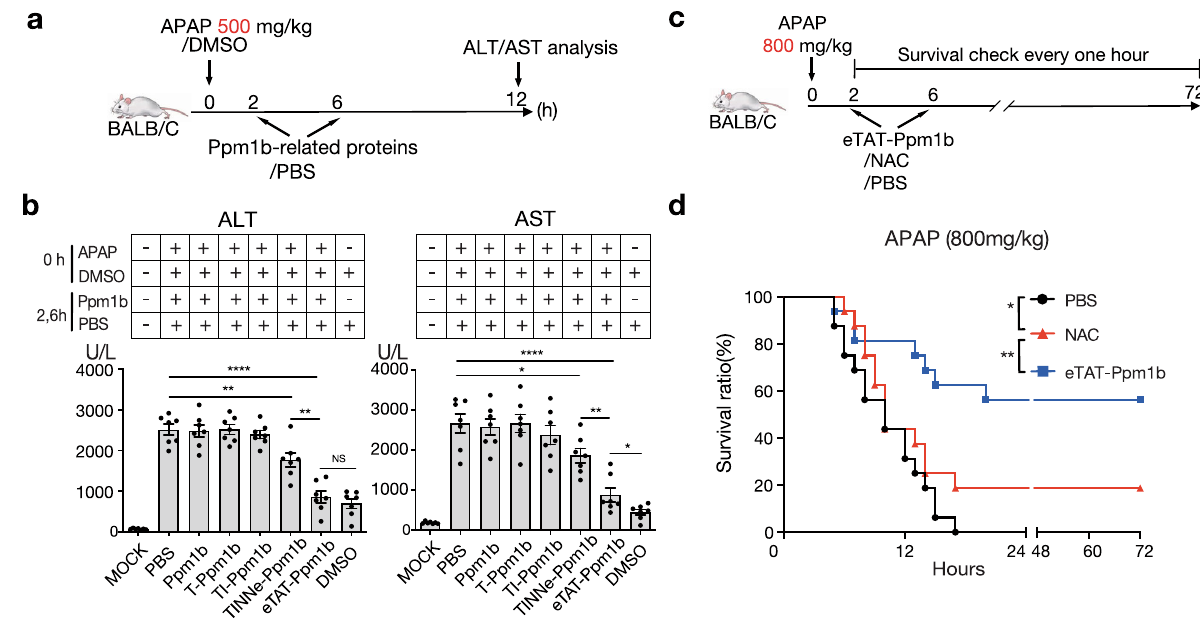
Fig. 4 eTAT-Ppm1b cures acetaminophen-induced acute liver failure. a , b eTAT-Ppm1b treatment of APAP-induced acute liver damage. Overnight-fasted female BALB/c mice were challenged intraperitoneally with APAP at a dose of 500 mg per kg body weight and then treated intravenously with Ppm1b- related recombinant proteins twice, 2 and 6 h after APAP administration ( a ). Twelve hours post-APAP challenge, serum was collected, and ALT and AST levels were determined ( b ). Mice treated with PBS were used as negative controls, and those challenged with DMSO solution and treated with PBS served as solvent controls. The mock mice received neither APAP nor Ppm1b-related proteins. All the values are expressed as the means± s.e.m., n = 7 for each group; * P < 0.05, ** P < 0.01, *** P < 0.001, **** P < 0.0001, and NS no signi fi cant difference; two-tailed unpaired student ’ s t test. c, d eTAT-Ppm1b therapy for attenuating APAP-induced death. Overnight-fasted female BALB/c mice were challenged intraperitoneally with APAP at a dose of 800 mg per kg body weight and then treated intravenously with Ppm1b-related recombinant proteins twice, 2 and 6 h after APAP administration ( c ). Then, the survival of the mice was monitored every hour for 72 h with the results presented in a Kaplan – Meier plot, and a log-rank (Mantel-Cox) test was performed; * P < 0.05, ** P < 0.01 ( d ). Mice treated with PBS were used as negative controls; n = 16 mice for each group pooled from two independent experiments. For data, statistics, and exact P values, see Source Data